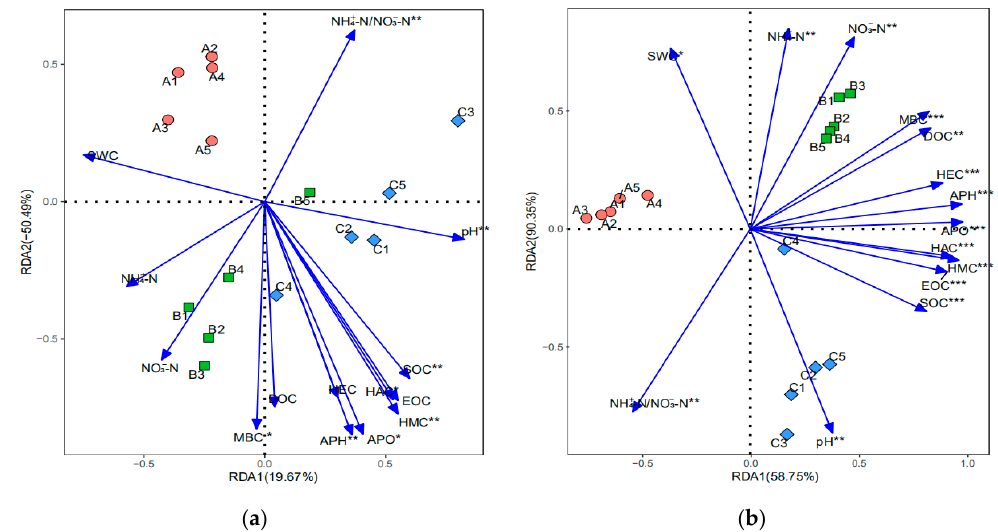
Figure 3. Redundancy analysis (RDA) demonstrating the significant relationships between soil physicochemical factors and ( a ) bacterial and ( b ) fungal communities. Red circles, green squares, and blue diamonds represent samples from sites A, B, and C, respectively. Soil physicochemical factors are represented as sold lines with filled arrows. * p < 0.05, ** p < 0.01, *** p < 0.001.